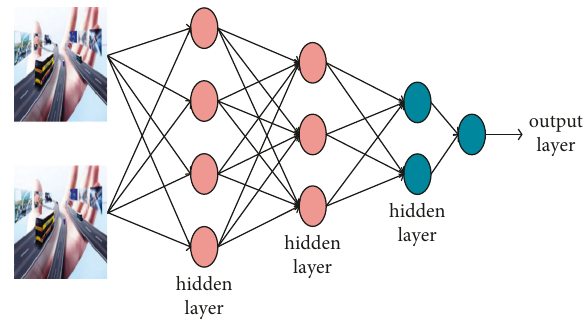
Figure 6: BP neural